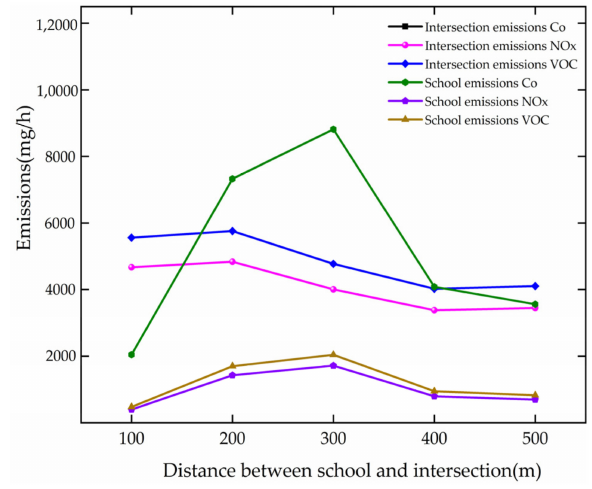
Figure 25. Variation trend of pollutant gas emission with DSI.